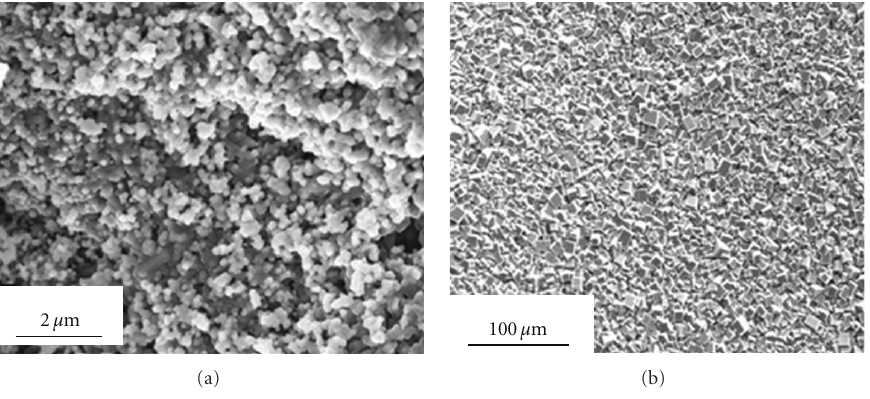
Figure 5: FESEM micrograph of (a) substrate with PVP intermediate layer with seed layer, (b) membrane layer synthesized on seeded substrate.